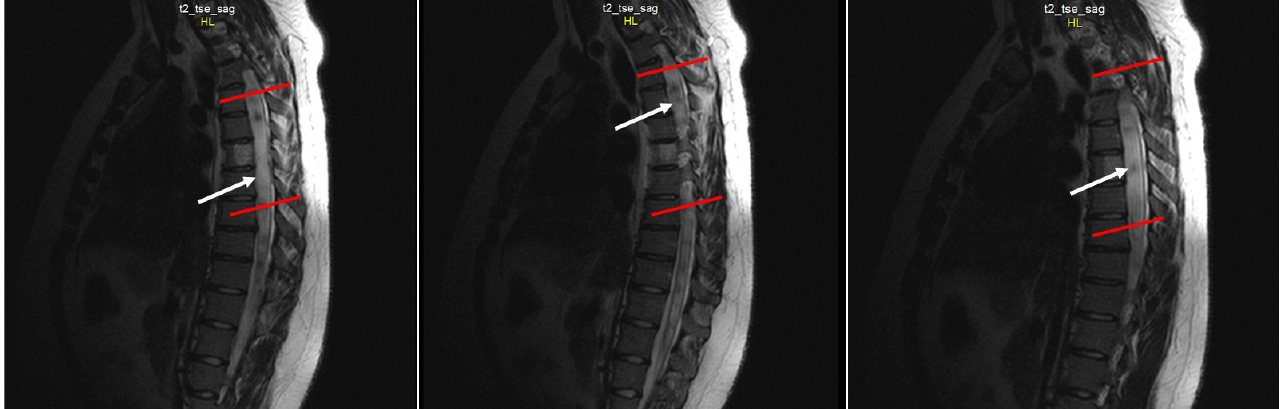
Figure 4. Sequential sagittal T2-weighted MRI scans of the thoracic spine demonstrate the syrinx (white arrow) extending inferiorly down to the Th12 level with the greatest dilation around Th3-Th7 (between the red lines).